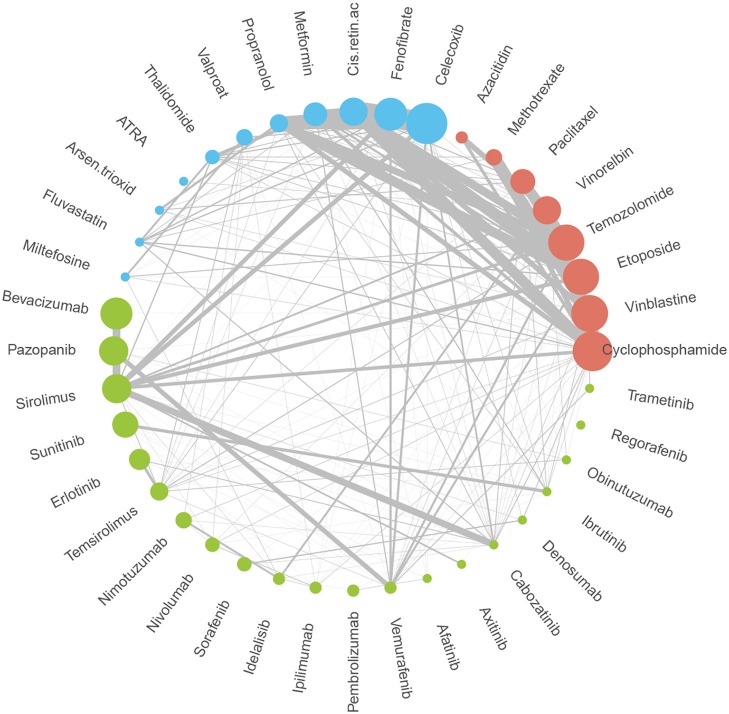
Drugs and combinations utilized during individualized treatment. Circle size is proportional to the number of patients receiving the drug during any phase of the treatment. Line thickness is proportional to patient-days using a specific combination of a drug in the sample during the treatment.